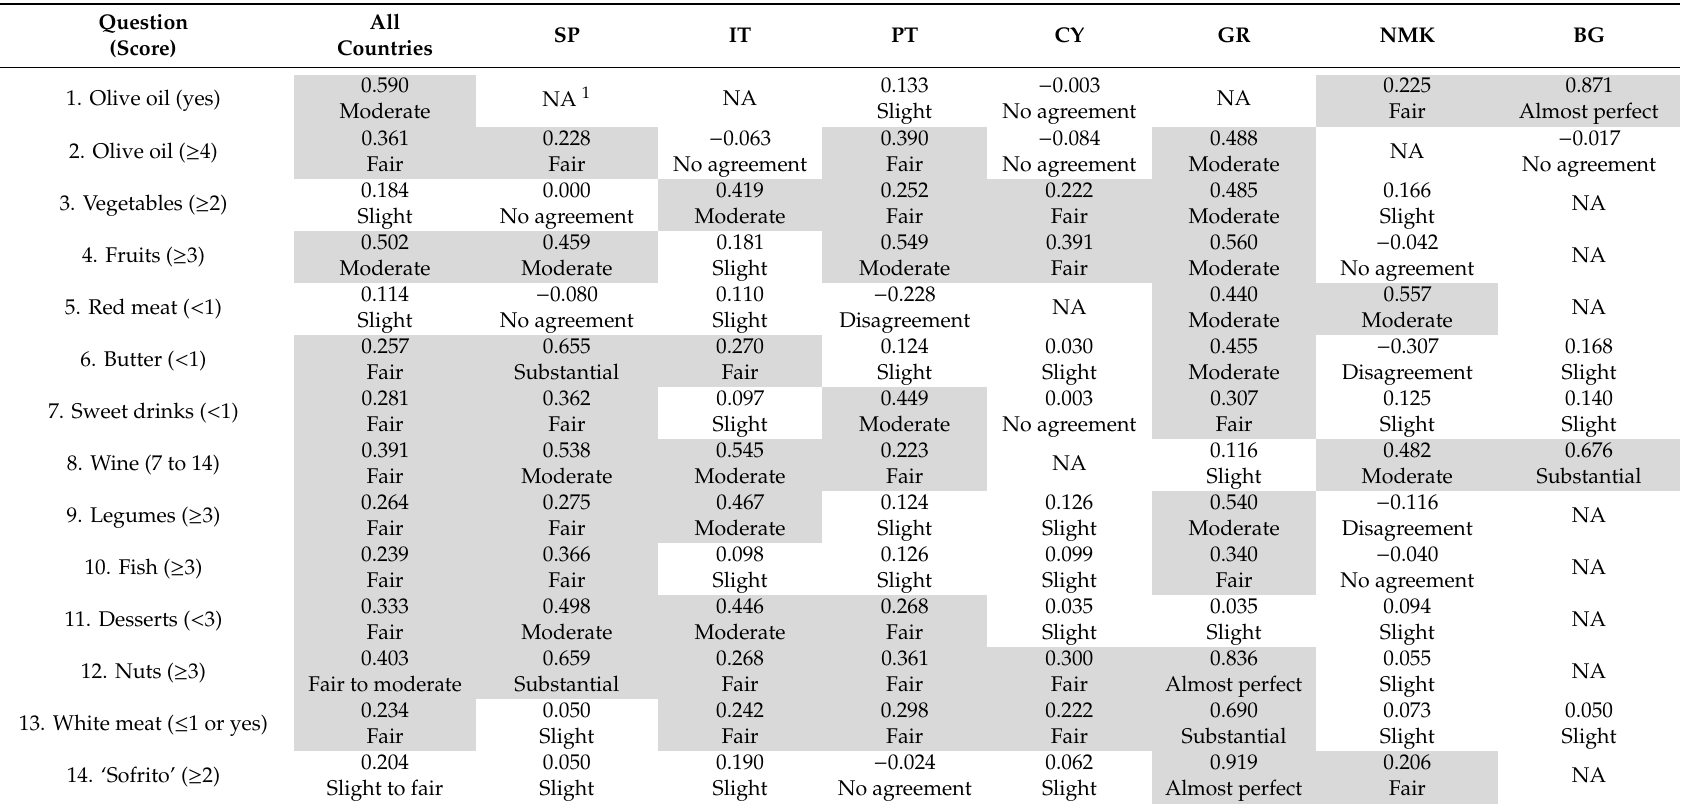
Table 3. Relative agreement (food frequency questionnaire (FFQ-MEDAS) vs. 3d-FD): per-item validation κ appa statistics analysis and level of agreement in all the